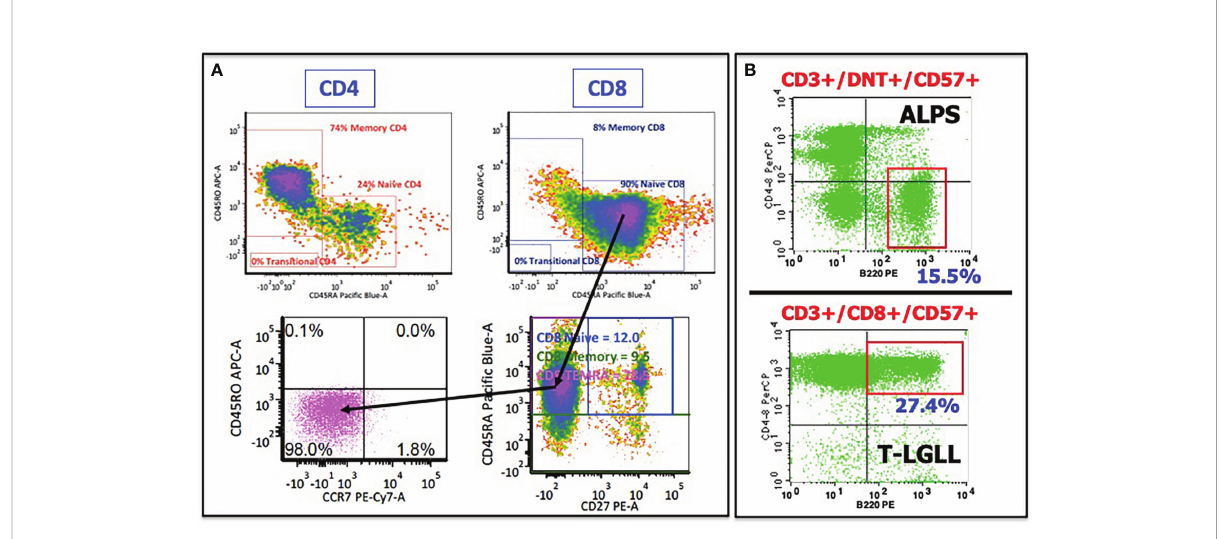
FIGURE 2 Illustrative fl ow cytometry cases showing abnormal T cells in several interface disorders. (A) Patient #3 from (8) demonstrated a discrepancy in CD45RO (memory) and CD45RA (naïve) expression between CD4+ T cells (upper left) and CD8+ T cells (upper right). Adding additional markers revealed that these CD45RA+/CD8+ T cells were not naïve T cells but rather TEMRAs (T-cell effector memory, RA-expressing), as determined by the lack of CD27 and CCR7 expression. (B) CD45RA-expressing T cells are also common in ALPS and in T-LGLL. Moreover, double-negative T cells in ALPS and T-LGL cells in T-LGLL express an unusual CD45RA isoform, B220. See text for further